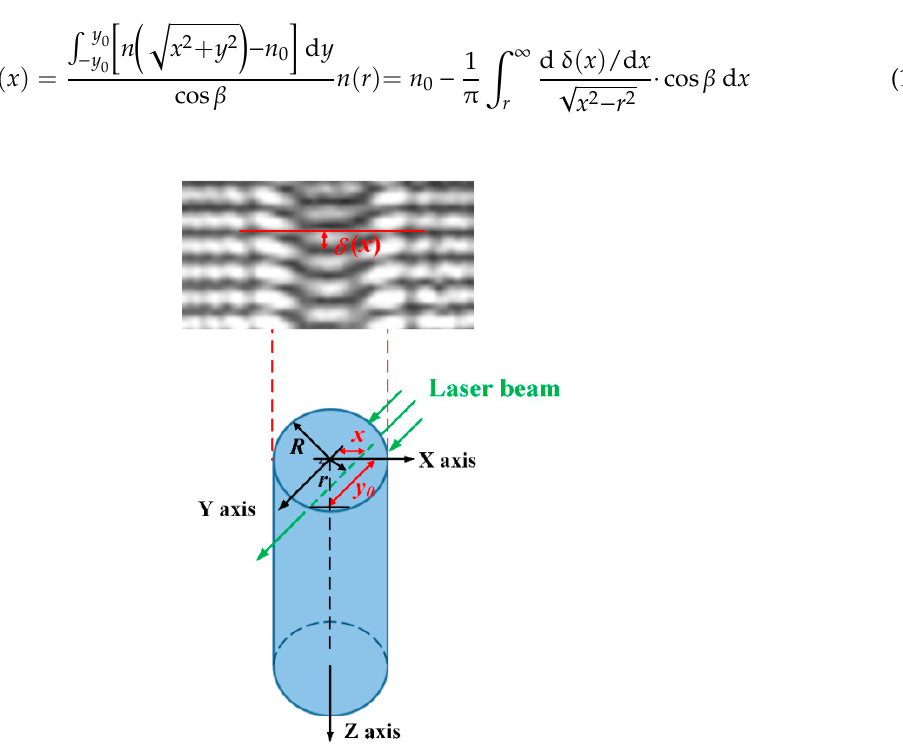
Figure 2. Diagram of the leader passing across a laser beam.